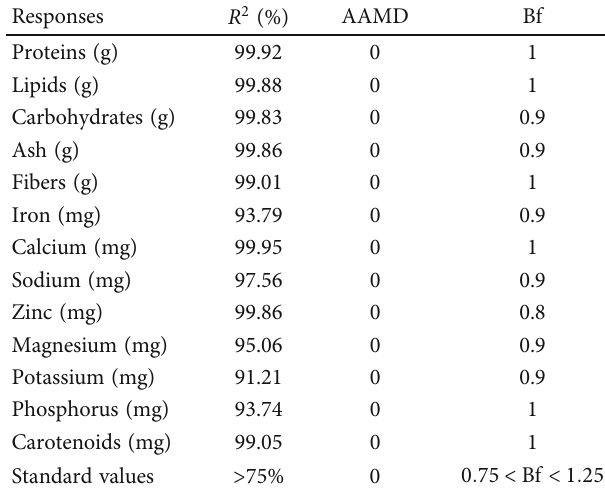
Table 3: Coe ffi cient of determination ( R 2 ), AAMD, and Bf of the di ff erent